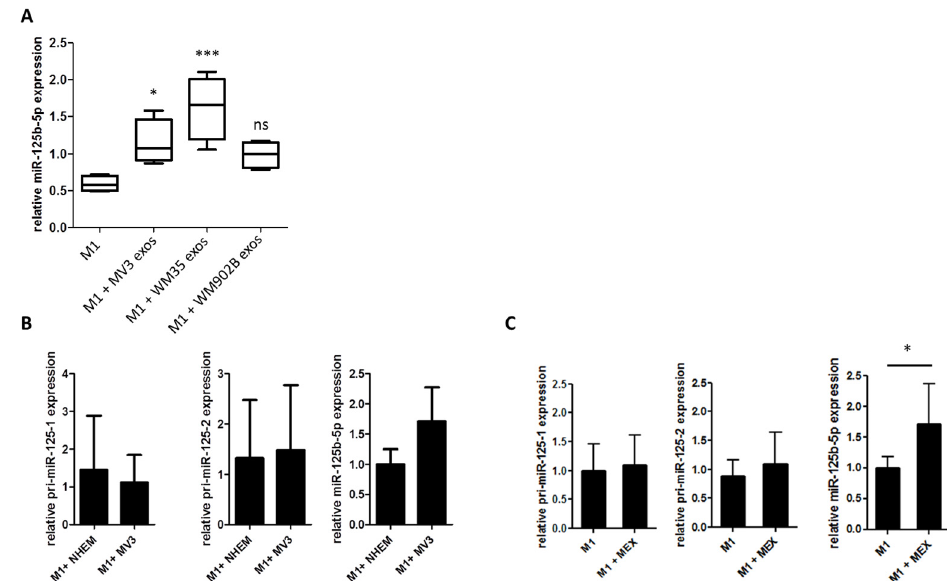
Figure 4. miR-125b-5p is delivered into M1 macrophages by melanoma-derived exosomes. ( A ) qRT-PCR for miR-125b-5p in THP-1-derived M1 macrophages with and without 48 h treatment with exosomes derived from different melanoma cell lines (* p ≤ 0.05; *** p ≤ 0.001; ns: not significant). qRT-PCR analysis of primary and mature transcripts of miR-125b after ( B ) co-culture (48 h) of THP-1-derived M1 macrophages with NHEM or MV3 melanoma cell line or ( C ) treated (48 h) with and without MV3-derived exosomes. Bars represent the average ± standard deviation of at least three independent experiments (* p ≤ 0.05).